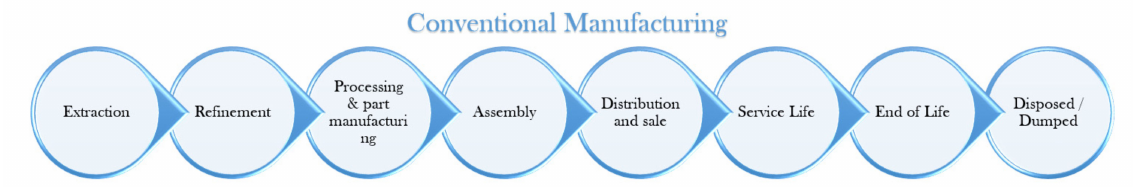
Figure 3. Major phases of conventional manufacturing (modified from [53]).